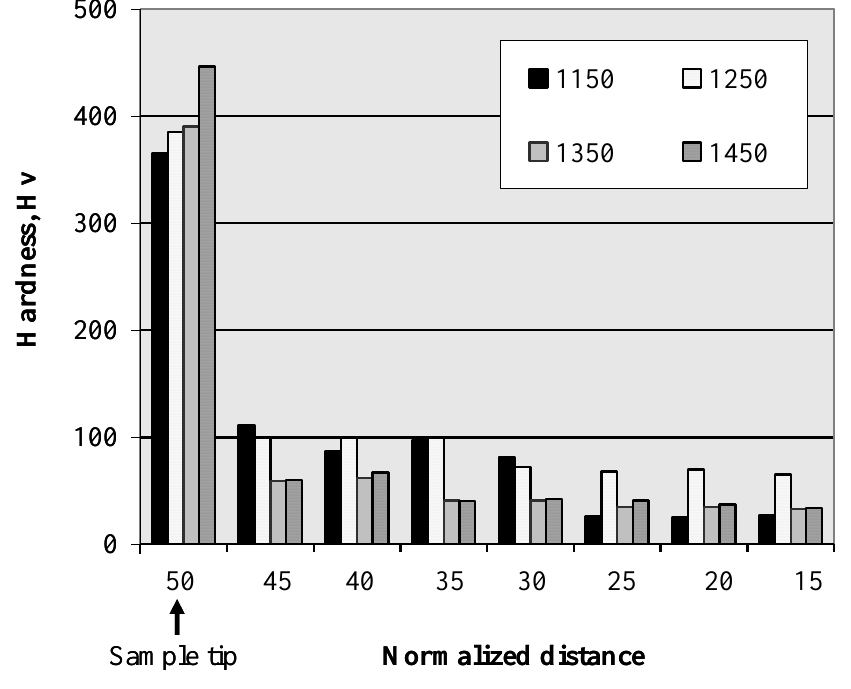
Figure 16. Vickers hardness distribution from the sample tip up to 35 mm of its length